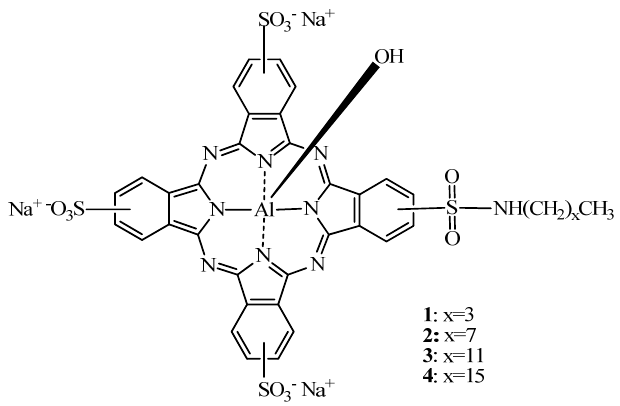
Figure 3. A homologous series of AlPc